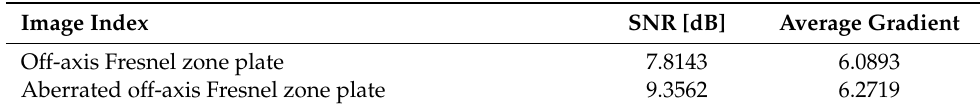
Figure 13. Imaging results: ( a ) Off-axis Fresnel zone plate; ( b ) aberrated off-axis Fresnel zone plate. In terms of the image metrics, the signal-to-noise ratio and the average gradient were used to quantitatively evaluate the images, as shown in Table 4. The signal-to-noise ratio represents the ratio of the image signal to the noise. The average gradient represents the clarity of the image. The larger the average gradient is, the clearer the image is. Compared with the images with the unimproved chromatography microscope, the signal-to-noise ratio of the images acquired by the improved laminar microscope increases by 18%, and the average gradient increases by 3%. Table 4. Laminar microscopy optical path image index.